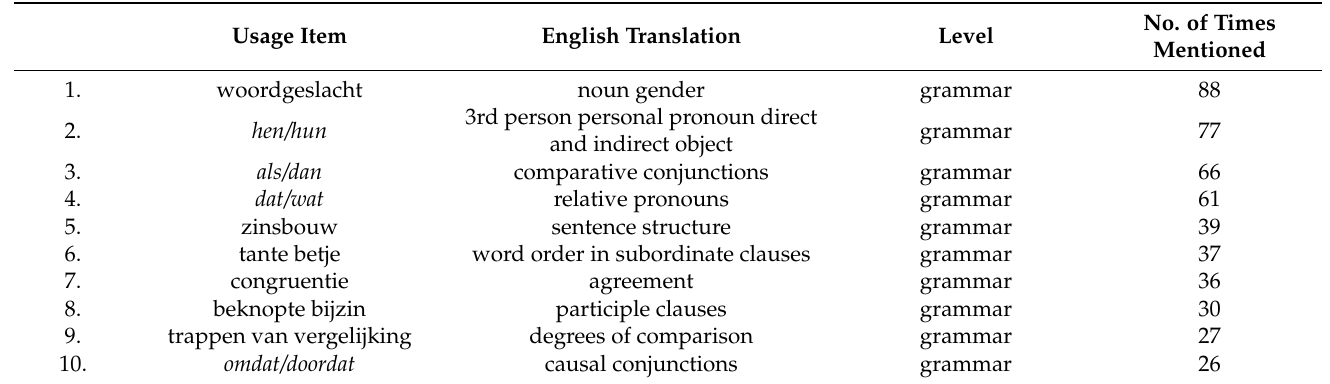
Table 3. Linguistic items mentioned more than once with recency statements.